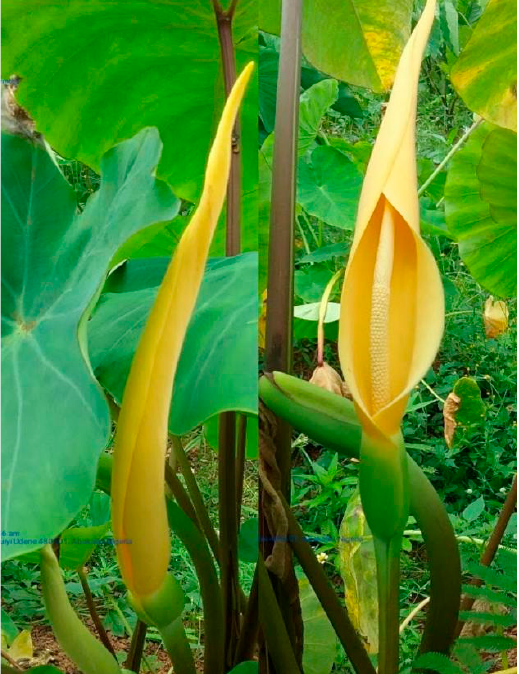
Figure 3. Inflorescence of C. esculenta . Photographed by the first author on 9 September 2021 during a visit to a farmer’s field in Agbaja azumili, Abakaliki, Ebonyi State, Nigeria. The taro cultivar is popularly known as “Ede ofe”.